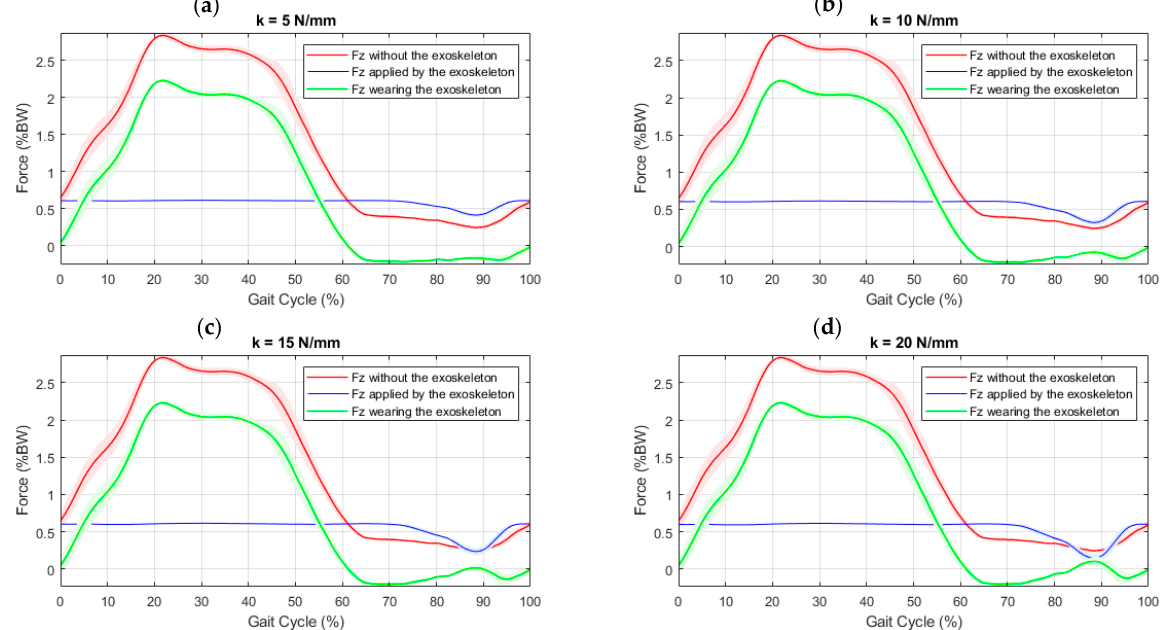
Figure 6. Study of the behavior of the system as a function of the spring constant for h = 100 mm: ( a ) k = 5 N/mm; ( b ) k = 10 N/mm; ( c ) k = 15 N/mm; ( d ) k = 20 N/mm. “Fz without the exoskeleton” is the force applied to the hip in a normal daily gait without wearing the exoskeleton, “Fz applied by the exoskeleton” is the absolute value of the longitudinal force exerted by the exoskeleton, and